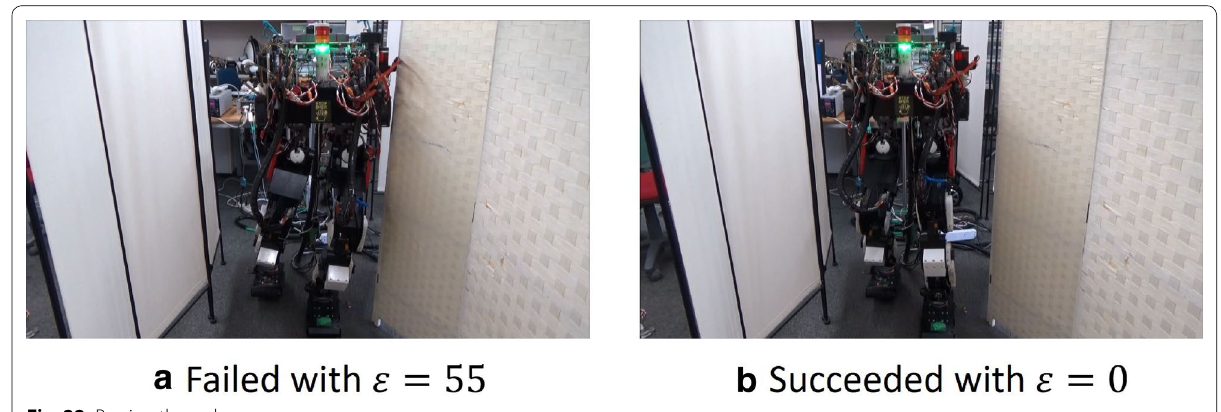
Fig. 22 Passing through narrow